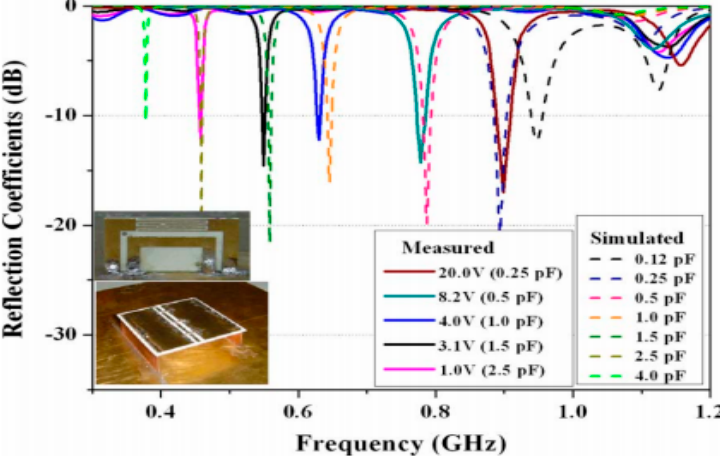
Figure 7. The reconfigurable antenna prototype and performance reproduced from [47]. 2020,